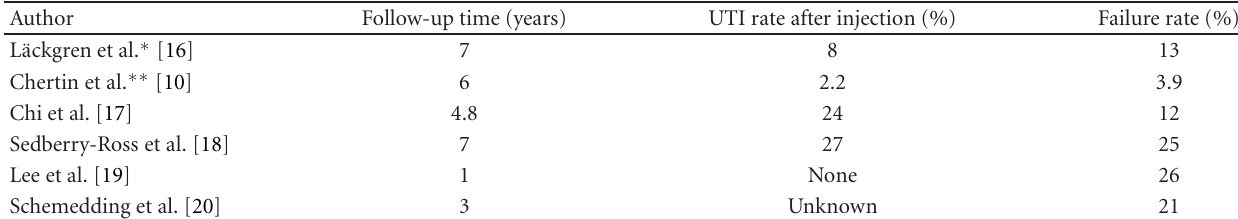
Table 2: Long-term results of endoscopic treatment of VUR with